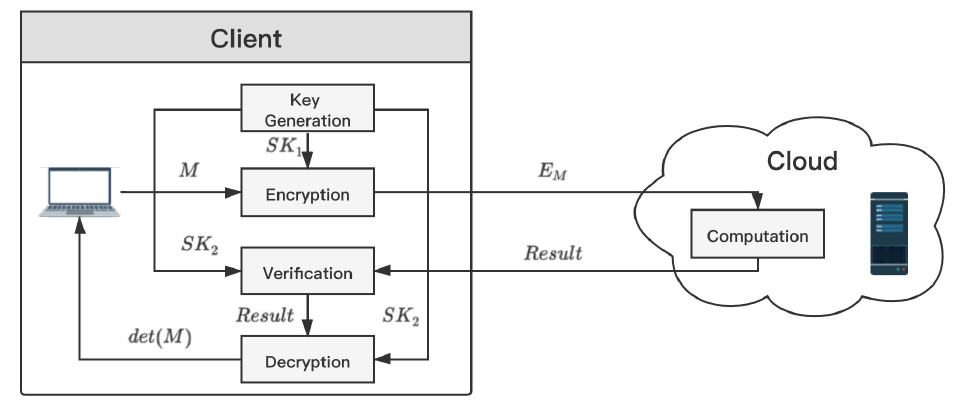
Figure 1. System model of secure outsourcing for matrix determinant